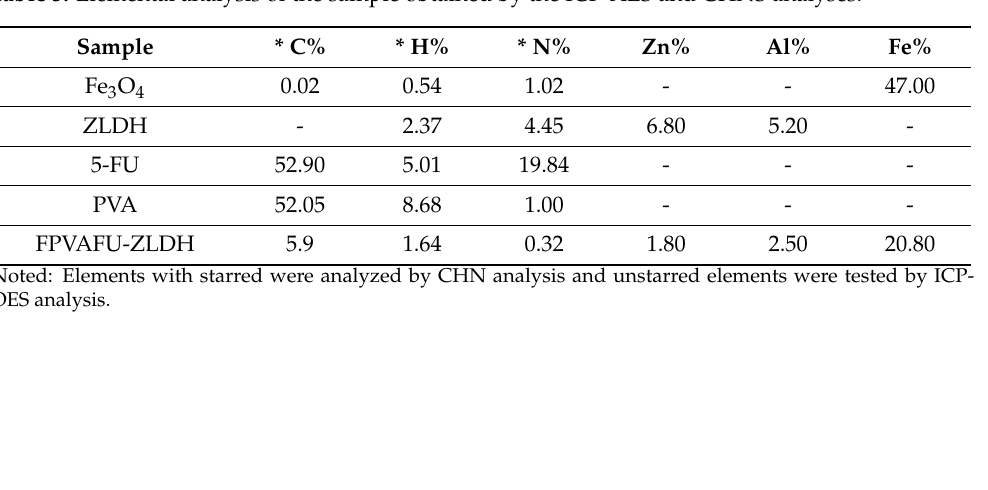
Figure 7. HRTEM micrographs of uncoated and coated samples: ( A ) Uncoated Fe 3 O 4 nanoparticles (50 nm bar); ( C ) FPVAFU-ZLDH (50 nm bar); and ( B , D ) show their particle size distribution, respectively. Table 3. Elemental analysis of the sample obtained by the ICP-AES and CHNS